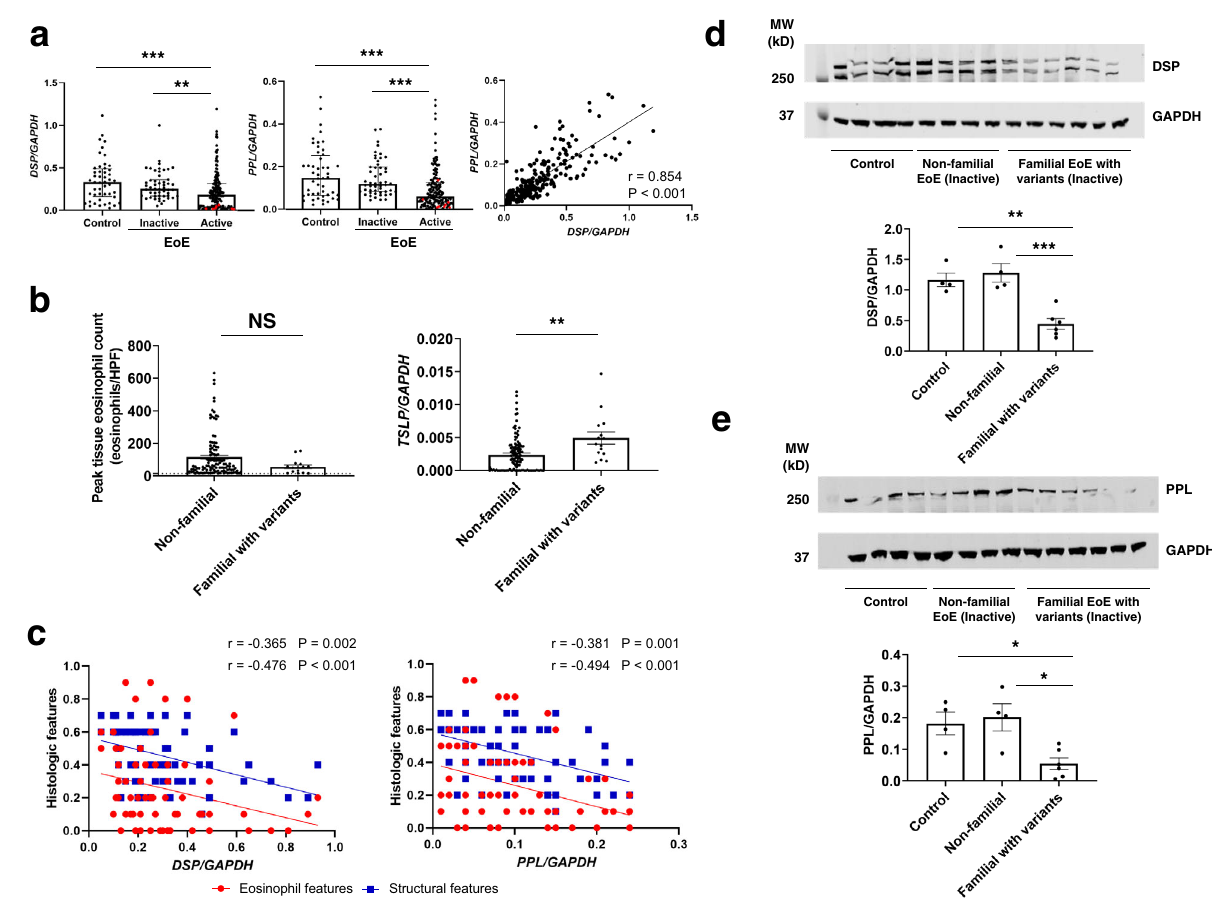
Fig. 2 Expression of DSP and PPL in patients with EoE. a DSP (left) and PPL (middle) mRNA expression in esophageal biopsies from controls and patients with non-familial EoE (inactive and active). Each point represents an individual subject [(Control, n = 48; Inactive EoE, n = 51; Active EoE, n = 147); red data points represent patients with DSP or PPL variants (not included in the statistics)]. Statistics: DSP (Control vs. Inactive EoE, P > 0.9999; Control vs. Active EoE, P = 0.0007; Inactive EoE vs. Active EoE, P = 0.009); PPL (Control vs. Inactive EoE, P > 0.9999; Control vs. Active EoE, P < 0.0001; Inactive EoE vs. Active EoE, P < 0.0001). Correlation plot of DSP and PPL mRNA expression is also shown (right) ( n = 246). Statistics: P < 0.0001. b Peak esophageal eosinophil counts (left) and TSLP mRNA expression (right) are plotted by groups for non-familial and familial EoE with DSP or PPL variants (non-familial EoE, n = 115; familial EoE with variants, n = 15). All samples were from the biopsies during the active disease state. The dashed line indicates the diagnostic threshold of EoE (15 eosinophil/hpf). Statistics: peak esophageal eosinophil count, P = 0.0927; TSLP , P = 0.0010. c Correlation plots of gene expressions (left: DSP , right: PPL ) and histologic scores (red: eosinophil features, blue: structural features) ( n = 68). Statistics: left ( DSP with eosinophil features, P = 0.0022; DSP with structural features, P < 0.0001), right ( PPL with eosinophil features, P = 0.0014; PPL with structural features, P < 0.0001). d and e Representative western blot analysis of DSP ( d ) and PPL ( e ) among control individuals ( n = 4), patients with non-familial EoE ( n = 4), and patients with familial EoE with DSP or PPL variants ( n = 6). GAPDH serves as a loading control. For patients with EoE, all samples were from the biopsies during the inactive disease state. Statistics: d (control vs. non-familial EoE, P = 0.7833; control vs. familial EoE, P = 0.0022; non-familial EoE vs. familial EoE, P = 0.0007), e (control vs. non-familial EoE, P = 0.9061; control vs. familial EoE, P = 0.0317; non-familial EoE vs. familial EoE, P = 0.0142). For panels a (left and middle), b, d and e , data are presented as mean ± SEM. For panels a – e , n is the number of biologically independent subjects. For panels a – e , two- tailed P -values were determined by the following tests: a (left and middle), Kruskal – Wallis test followed by a Dunn multiple-comparison test; b , the unpaired t -test; a (right) and c , Spearman ’ s rank correlation coef fi cient (multiple comparisons were not applied); and d , e , one-way ANOVA test followed by a Tukey ’ s multiple comparisons test. * P < 0.05, ** P < 0.01 and *** P < 0.001. EoE eosinophilic esophagitis, DSP desmoplakin, PPL periplakin, GAPDH Glyceraldehyde 3-phosphate dehydrogenase, hpf high-power microscopic fi eld, IQR interquartile range, DAPI 4',6-diamidino-2-phenylindole, MW molecular weight, NS not signi fi cant, SEM standard error of the